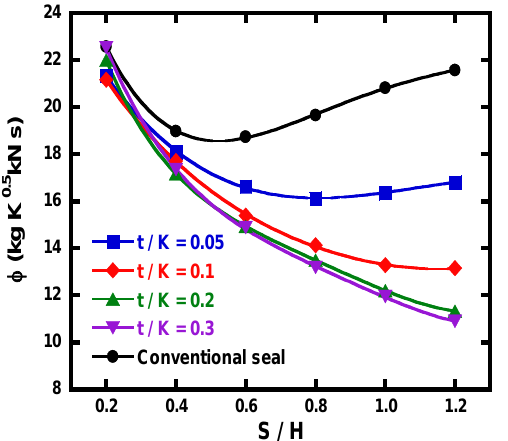
Figure 11. Variation in the flow function with S/H and t/K (PR = 2.5).